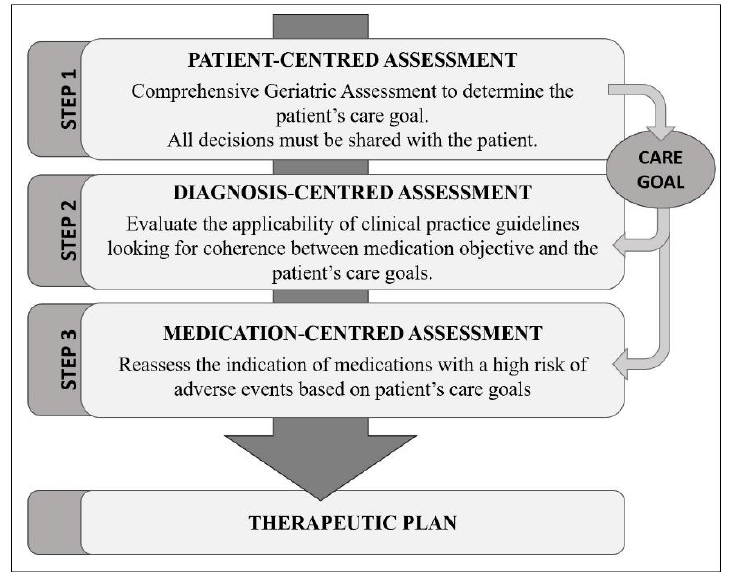
Figure 1. Patient-Centred Prescription model.